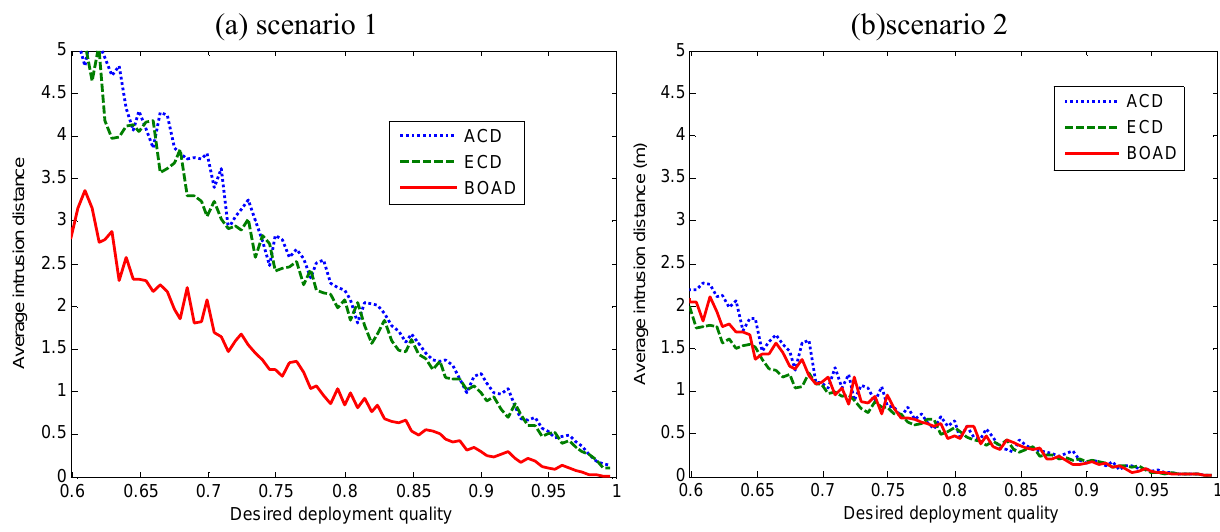
Figure 8. Comparison average intrusion distance of three deployment strategies with sensing radius r = 15 m. (a) The intrusion comes from the boundary of the monitored region. (b) The intrusion comes from inside the monitored